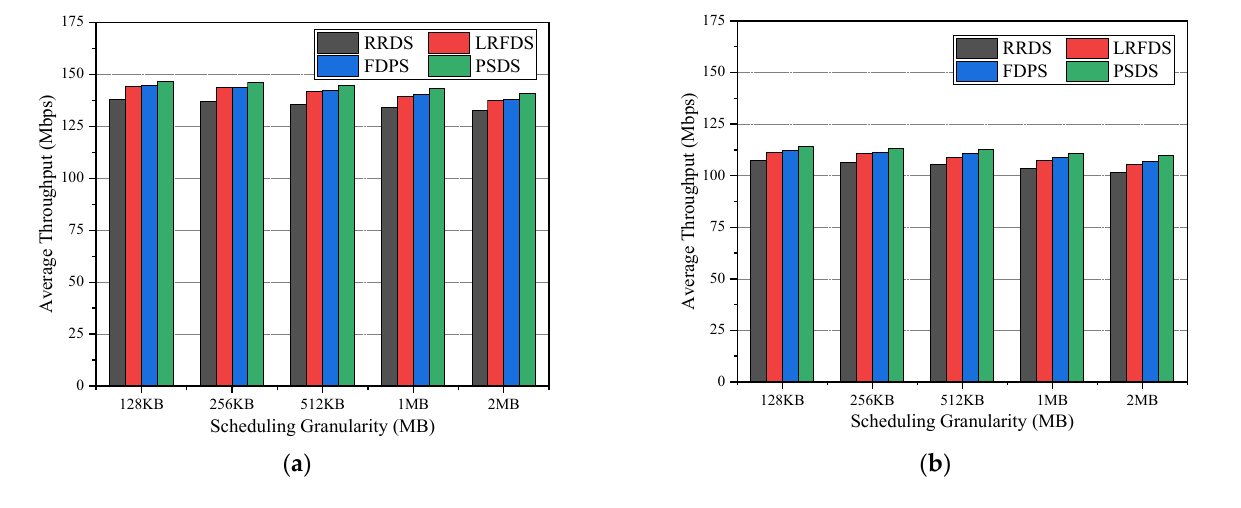
Figure 12. Average throughput under different scheduling granularities: ( a ) BT North America; ( b ) GEANT.